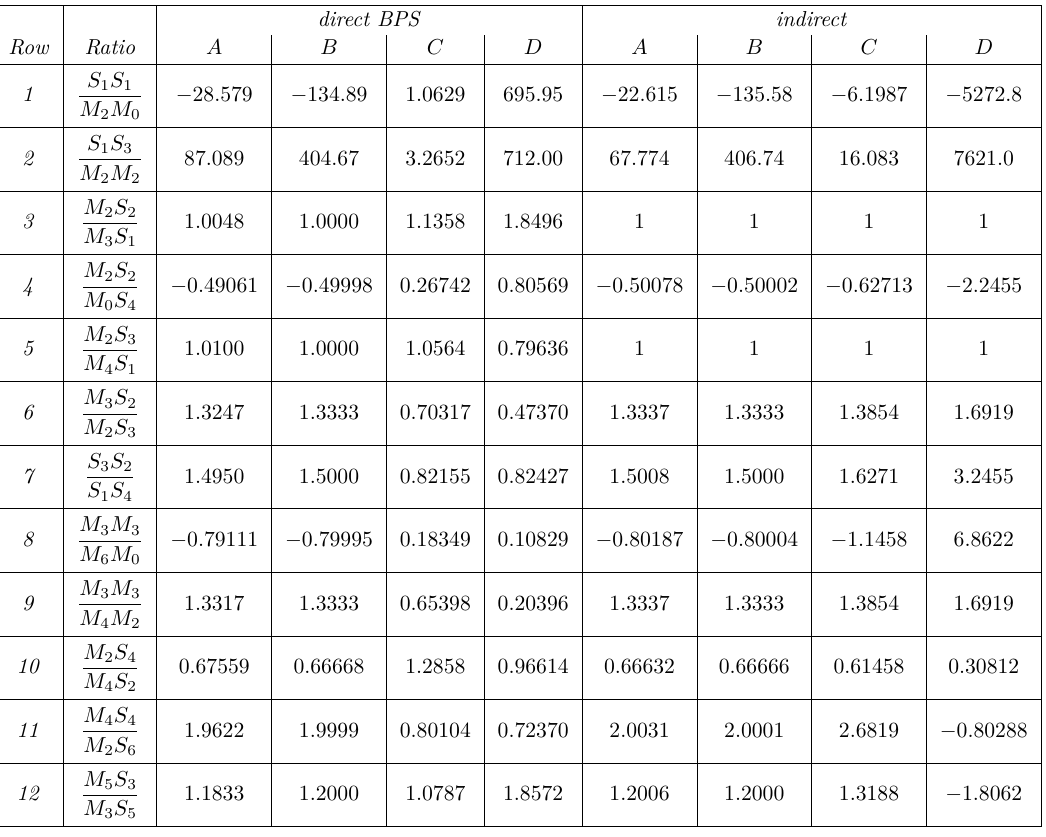
Table 1. Several mixed mass-current (dimensionless) multipole ratios for the four-center solutions of section 4.3.2, computed using the direct BPS and the indirect